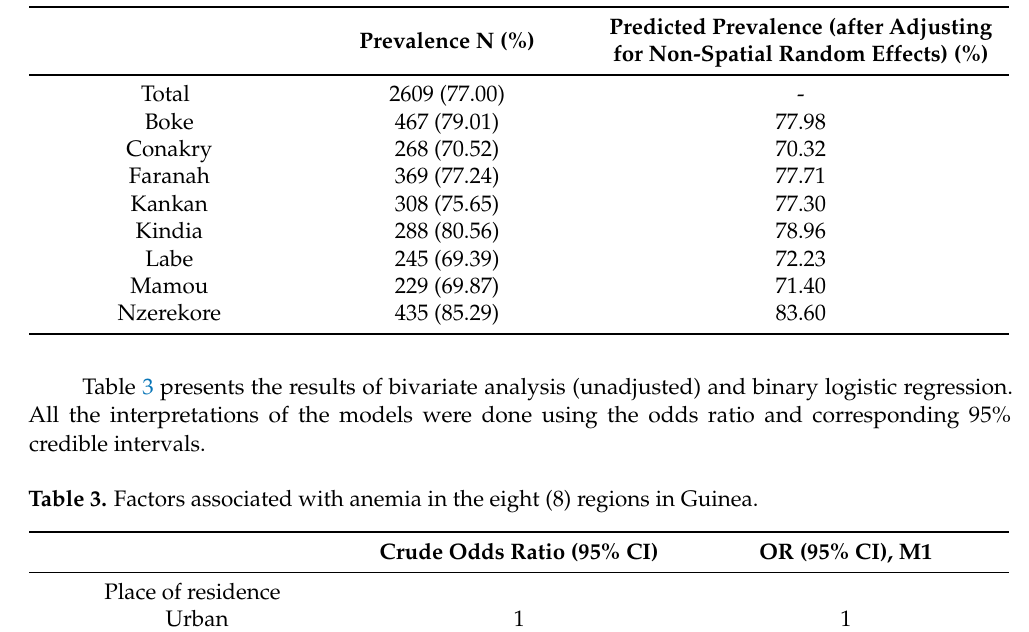
Table 2. Prevalence of anemia by region.